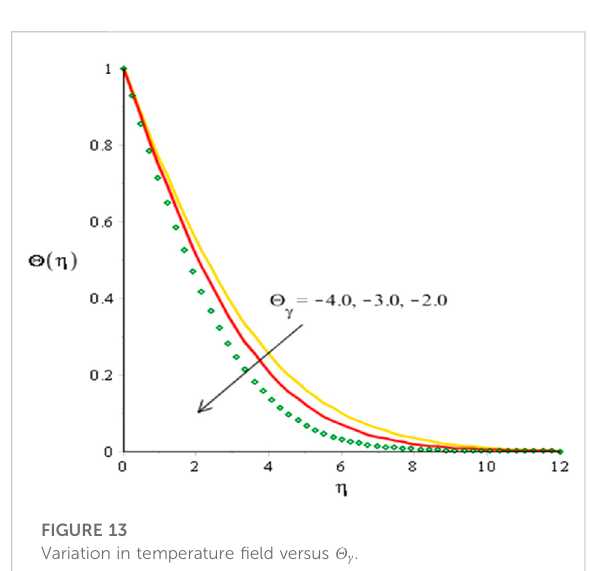
FIGURE 11 Variation in temperature fi eld versus Pr .